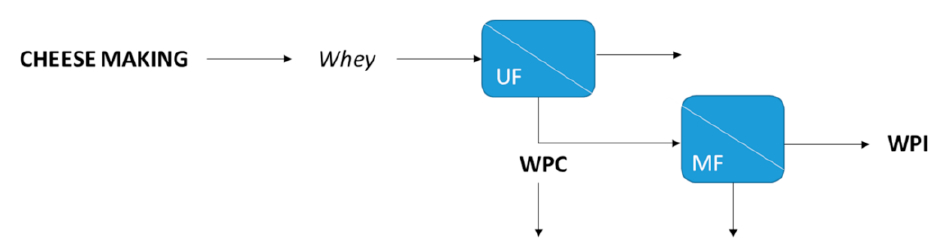
Figure 5. WPC and WPI production from cheesemaking by integration of UF and MF (adapted from [32]).